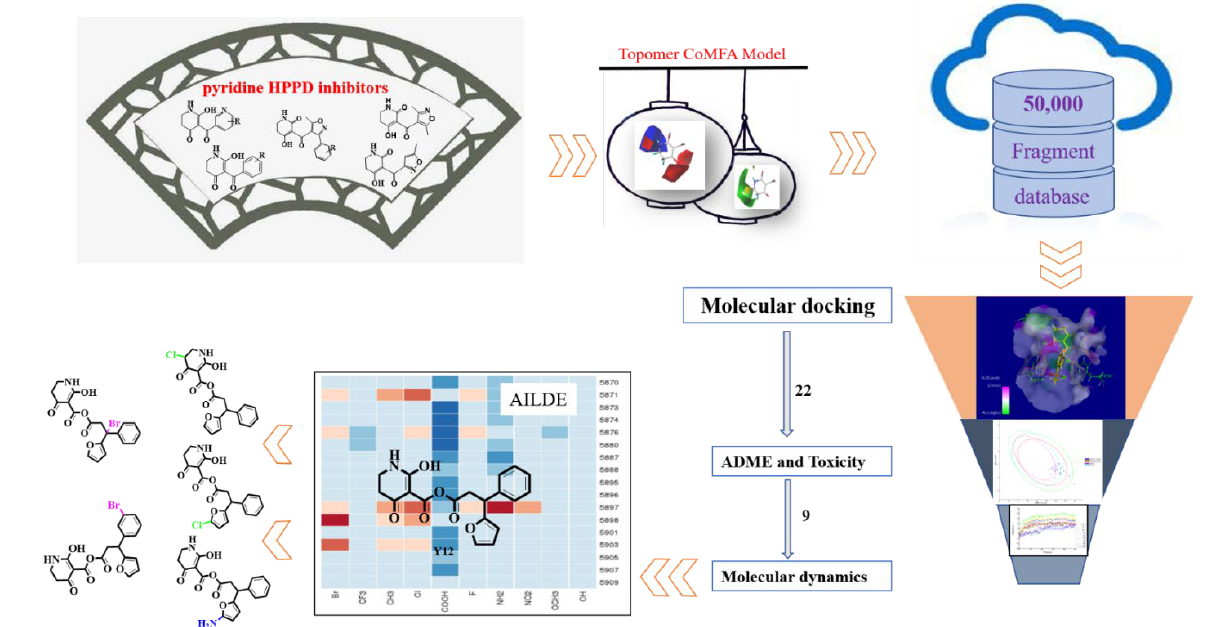
Figure 1. The screening workflow applied to design novel HPPD inhibitors.